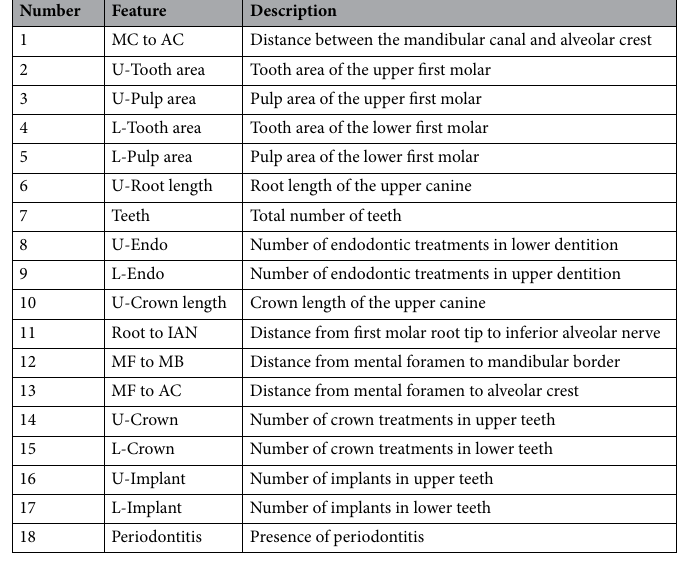
Table 1. Eighteen selected features in panoramic radiograph and their brief